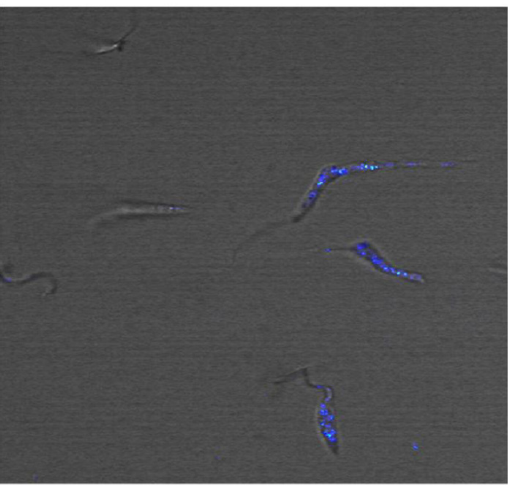
Figure 2. Live parasites imaging using QDs bioconjugates with lectin ( Sambacus Agglutinin Nigra —SNA) (After Feder et al . 2009